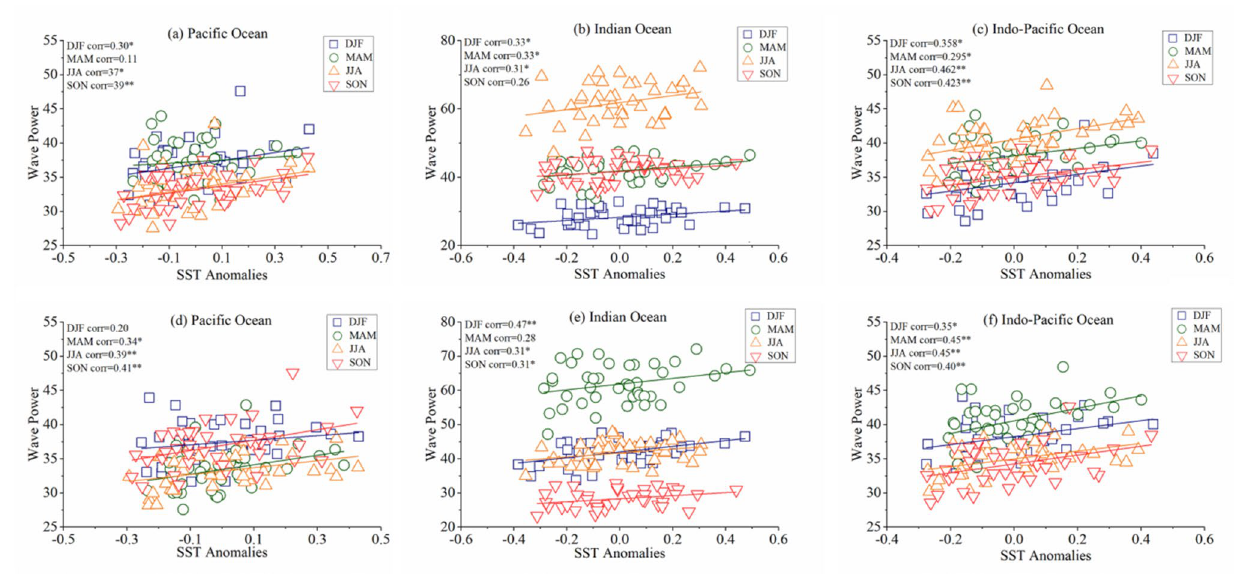
Figure 3. Seasonal interrelation between the mean WP and SST anomalies over the ( a ) Pacific Ocean, ( b ) Indian Ocean, and ( c ) Indo-Pacific Ocean over the period 1979–2019. Statistically significant correlations at the 99% and 95% level of confidence are indicated by ** and *, respectively. ( d – f ) The same as in ( a – c ) except between SST during a given season and WP one season after (i.e. time lag =